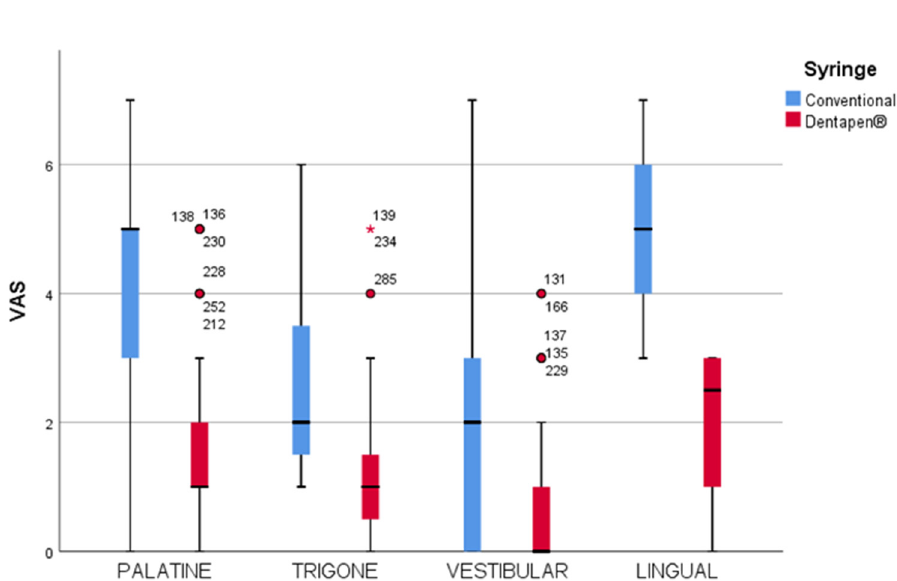
Figure 2. VAS comparison based on the area of injection and the type of syringe used. BOX-PLOT. VAS comparison based on the area of injection and the type of syringe used.